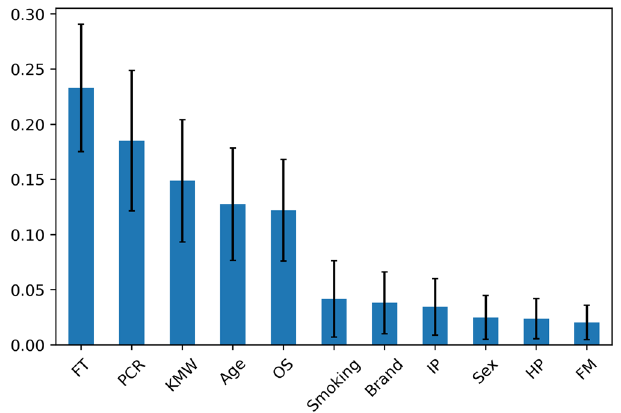
Figure 3. Mean values of feature importance in the RF prediction model. The error bars represent standard deviation. FT: functional time, PCR: plaque control record, KMW: keratinized mucosa width, OS: number of occlusal supports, IP: implant position, HP: history of periodontitis and FM: fixation method. This figure was created with Python version 3.7.7 (Python Software Foundation, Beaverton, OR).